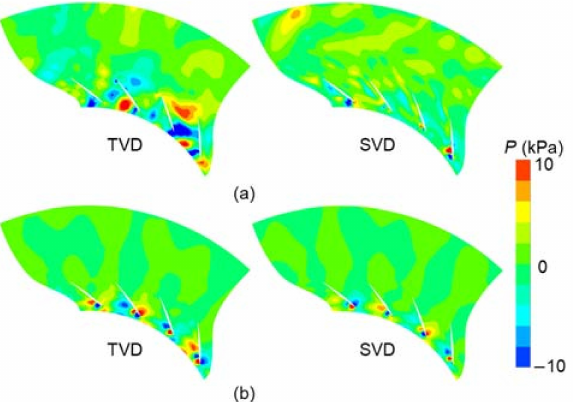
Figure 22. The pressure fields for DMD modes of two specific frequencies at 0.95 span: ( a ) 86.645 Hz; ( b )